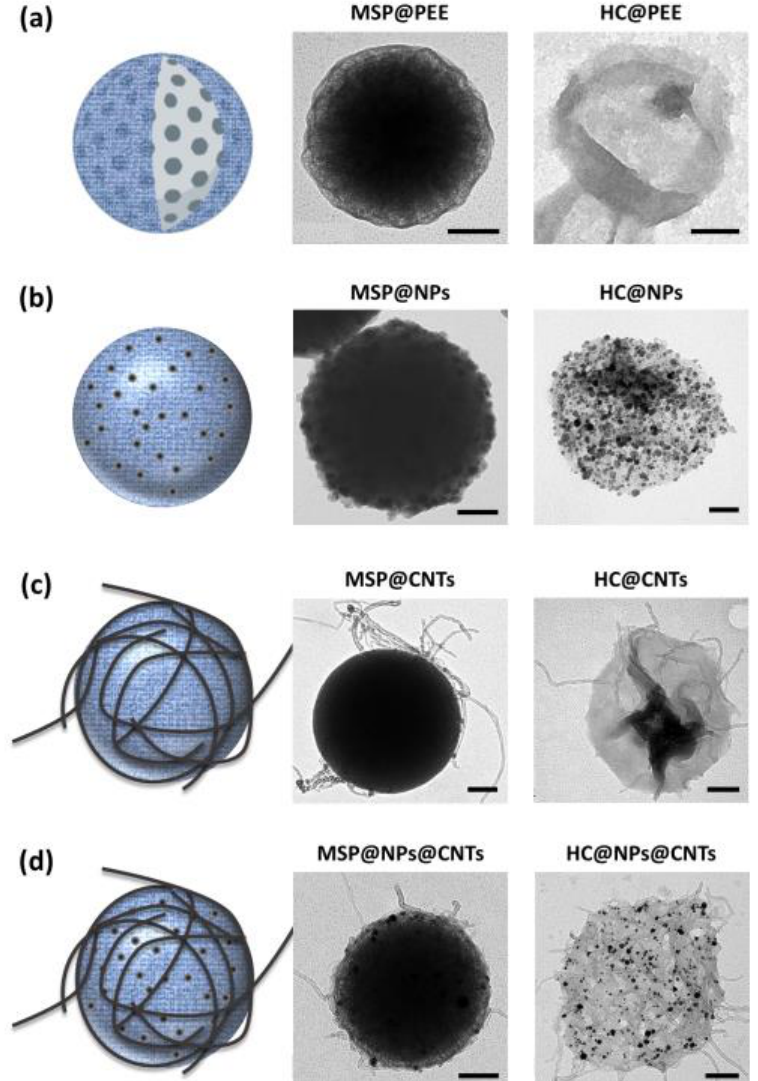
Figure 2. Diagrams and TEM images of different examples of hollow polyelectrolyte (PEE) capsules. MSPs, before and after silica core dissolution. ( a ) MSP coated with PEE and the resulting hollow capsule (HC@PEE). ( b ) PEE capsules decorated with nanoparticles (NPs), in this case, CoFe 2 O 4 NPs. ( c ) PEE capsules decorated with carbon nanotubes (CNTs), in this case, oxidized multi-walled CNTs (MWCNTs). ( d ) Example of PEE hollow capsules decorated with NPs and CNTs, in this case, Pt NPs and ox-MWCNTs. Scale bar corresponds to 100 nm.